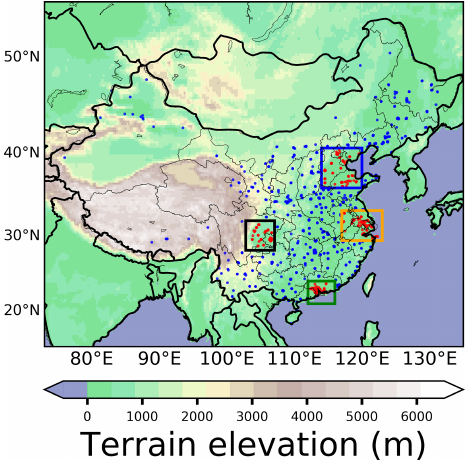
Figure 1. Elevation height (m) and locations of all ground-based stations and the four megacity cluster regions, BTH (blue box; 114– 120 ◦ E, 36–40.62 ◦ N), YRD (orange box; 117–123 ◦ E, 29.458– 33.238 ◦ N), PRD (green box; 112–116 ◦ E, 21–24.111 ◦ N), Sichuan (black box; 102.8–107.061 ◦ E, 28.2–31.976 ◦ N). Red (blue) dots in- dicate the locations of stations within (outside) the four